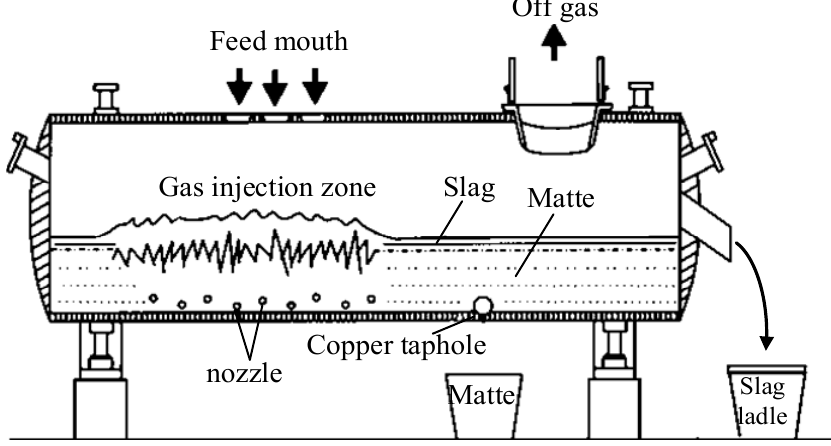
Figure 1. Schematic diagram of bottom blown copper smelting furnace.